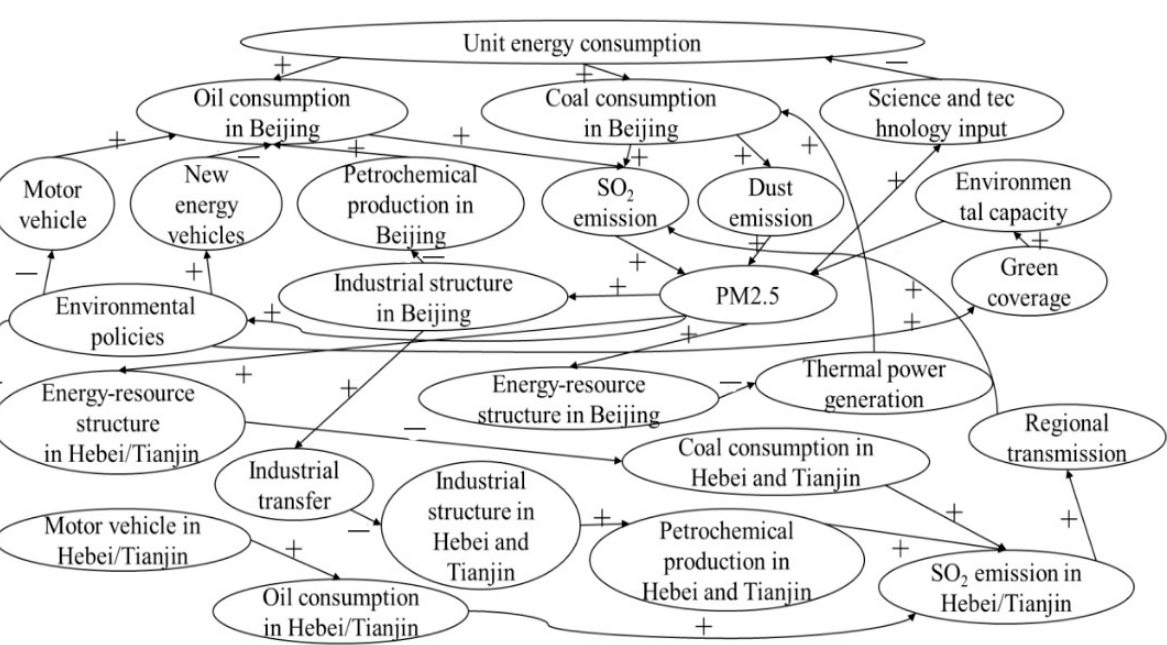
Figure 9. Overall causality diagram of Beijing urban haze system.